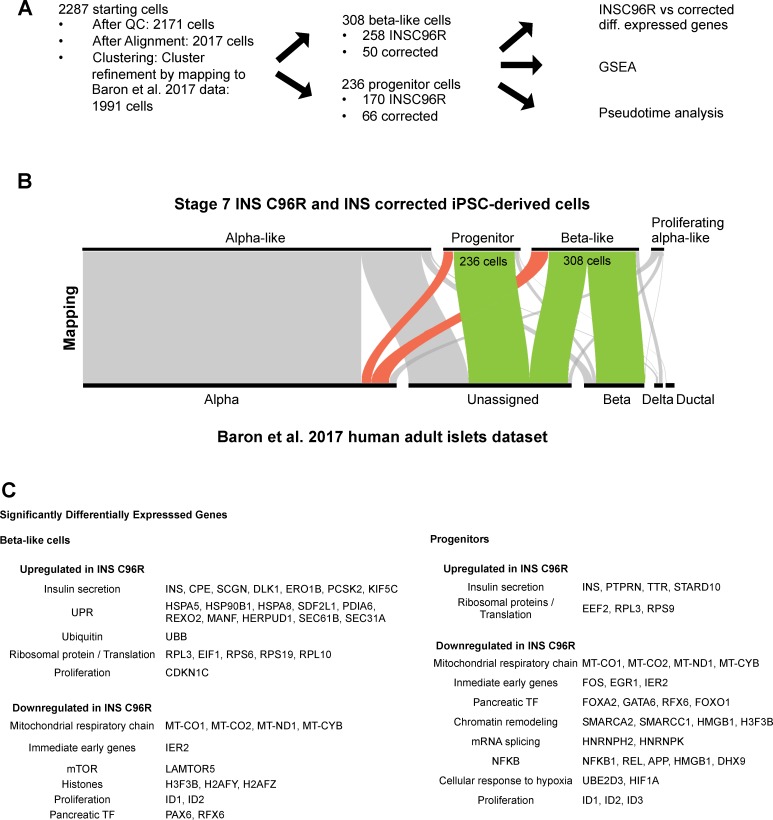
Single cell RNA sequencing data analysis strategy.(A) Steps in the analysis of the scRNAseq data. (B) Clustering refinement by mapping the Stage 7 scRNAseq cell clusters to the published InDrop dataset of human adult islets by Baron et al. (2016). (C) Selected summary of gene sets that are up- and down-regulated between INS C96R and INS corrected cells in beta-like and progenitor clusters. See also Supplementary file 1 – Tables 3-6.